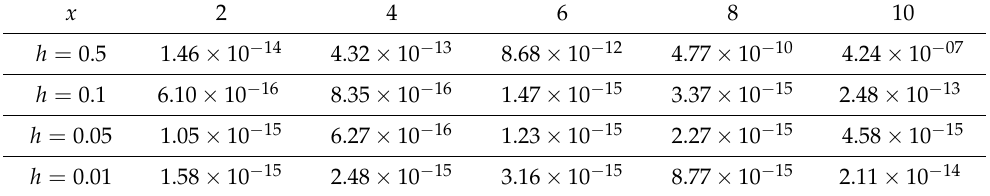
Table 11. Relative errors for the nonlinear matrix problem (35) solved by a spline of order m = 12. x 2 4 6 8 h =